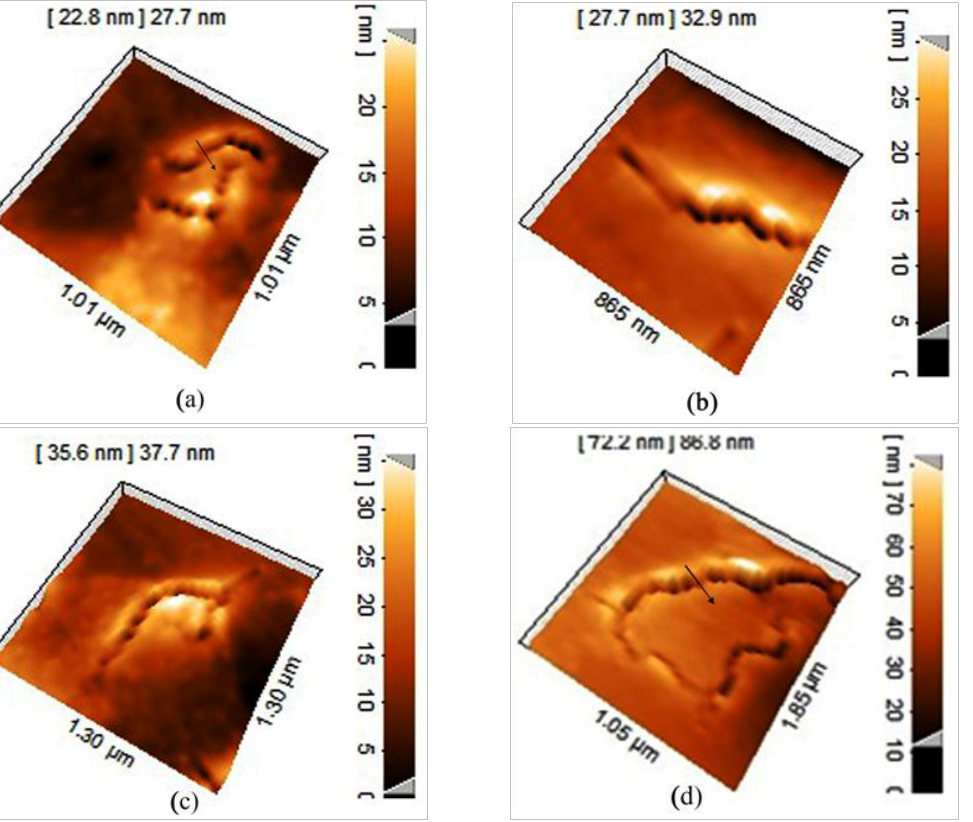
Figure 4. Depth profile of DNA strands remaining on the Al surface ( a ) after 10 min; ( b ) after 20 min; ( c ) after 30 min; and ( d ) after 40 min.